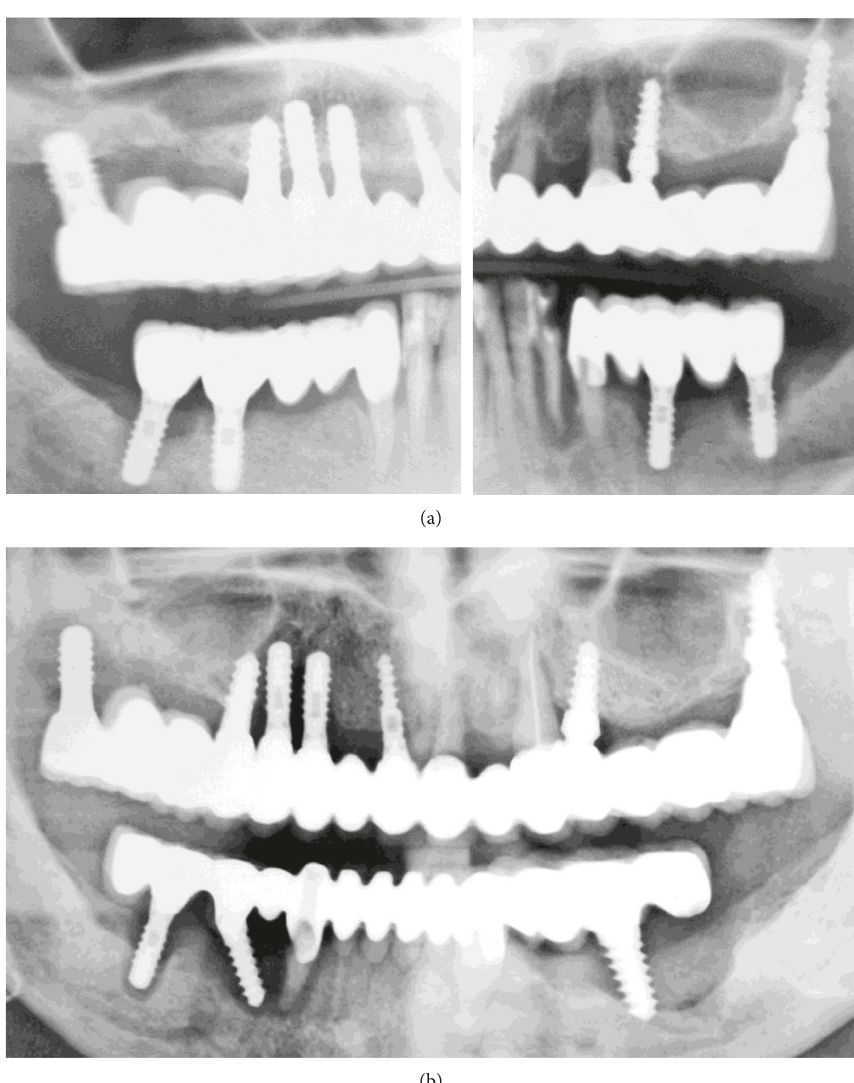
Figure 4: OPGs. (a) Further progression of bone loss on November 2009 (not modified radiograph taken during current treatment). (b) At initial examination in June 2015 (not modified radiograph taken during current